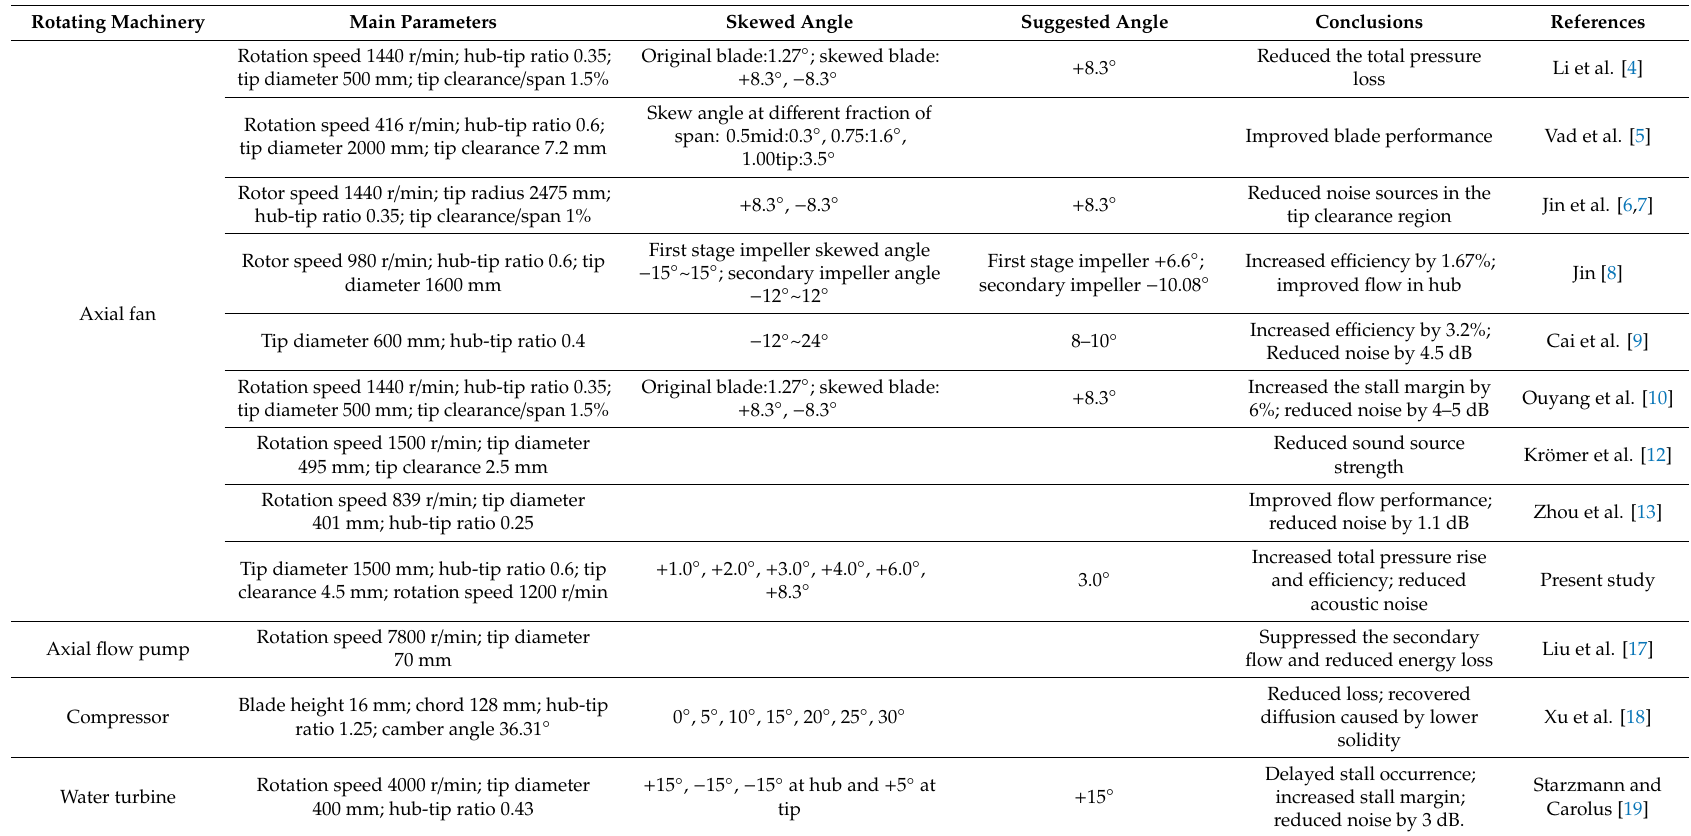
Table 1. Comparison of skewed blades in the published literatures and present